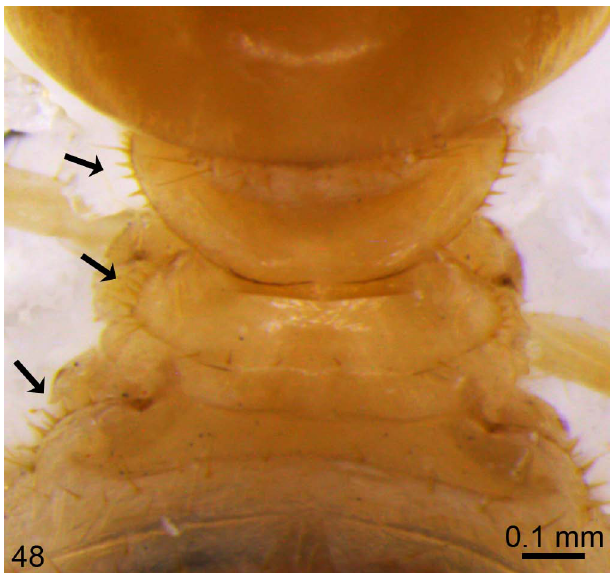
Fig 48. Thoracic nota of Armitermes armiger worker (arrows: serrated margins).